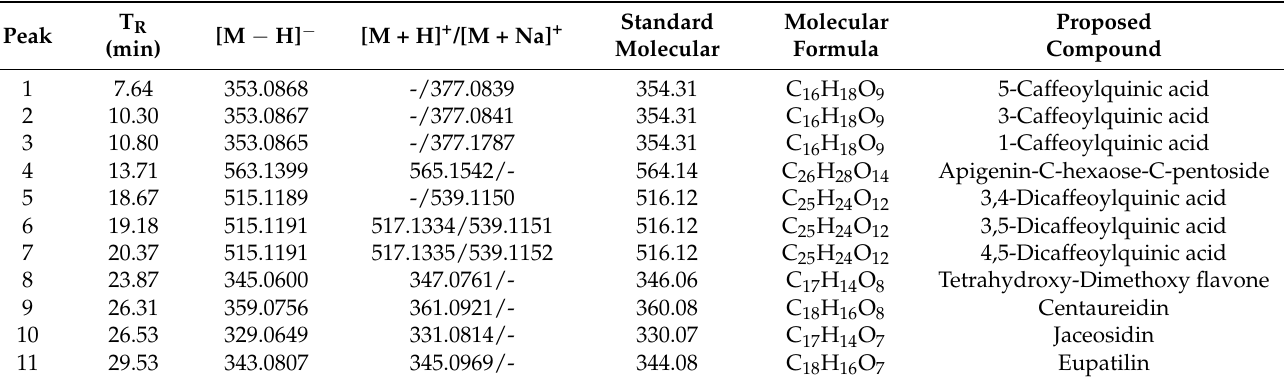
Table 1. Identified or tentatively identified compounds in ALE by HPLC-MS under both positive and negative ion mode.